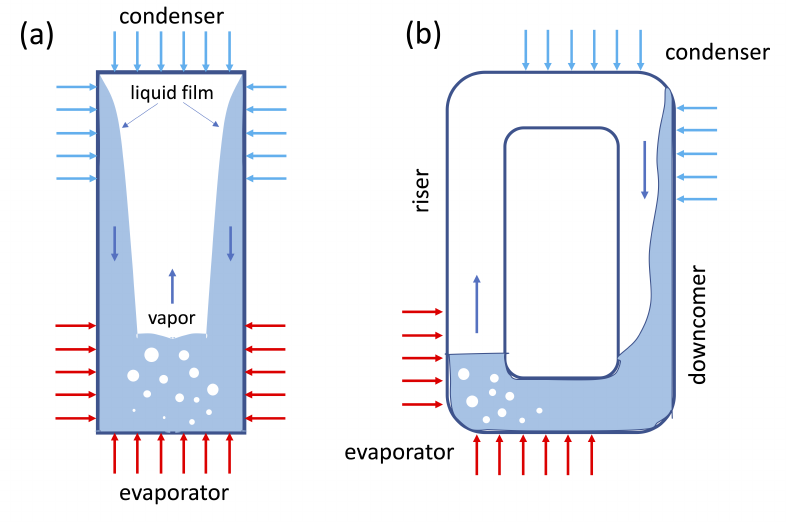
Figure 2. Schematic of single thermosyphon pipe ( a ) and loop thermosyphon pipe ( b )